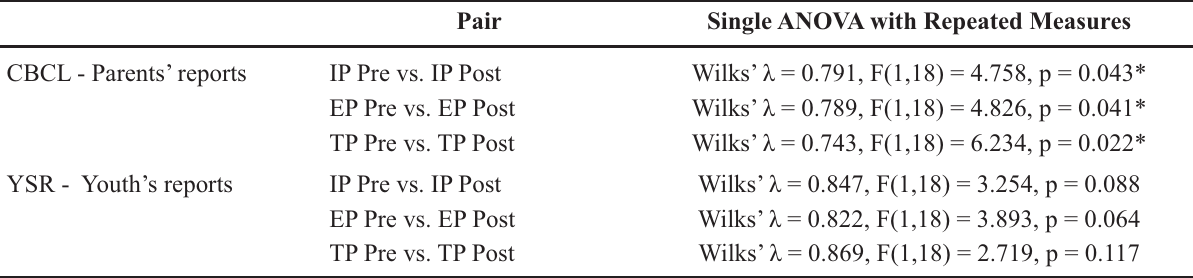
Table 1 – Differences between evaluation data pre and post